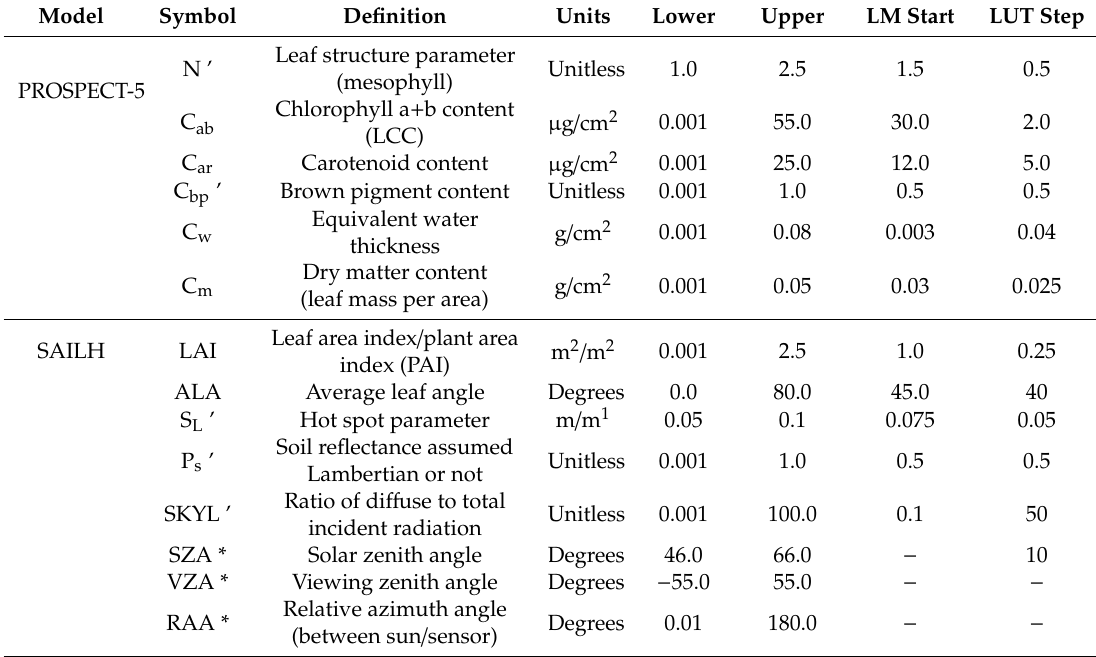
Table 2. PROSAIL parameters used to constrain the data simulations and numerical inversion. (*) Known values held constant (fixed) for the model inversions. (’) Values based on the literature. Unitless values are of no